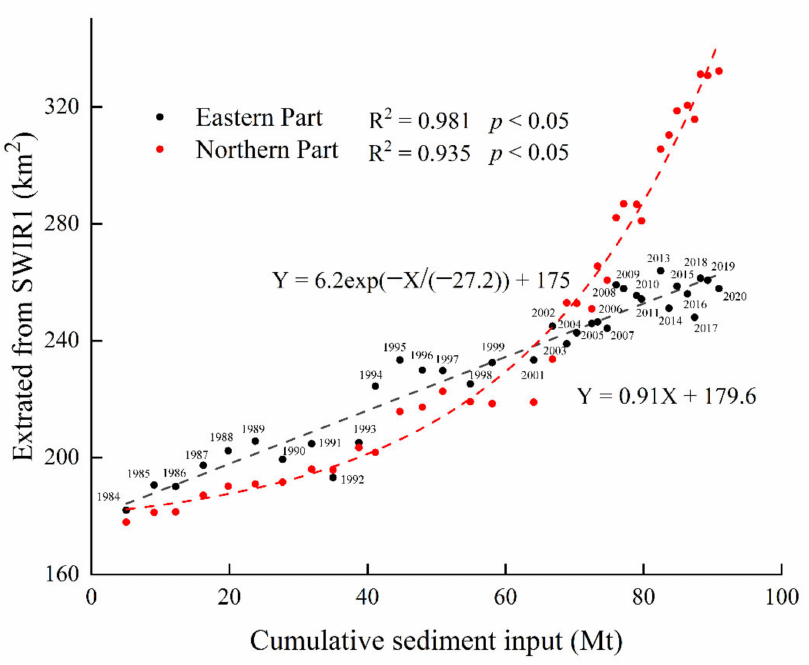
Figure 7. Relationship between sediment accumulation and the extracted areas of the eastern and northern shorelines on Chongming